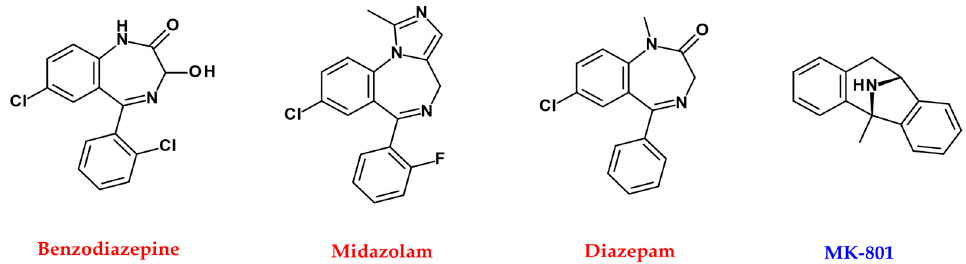
Figure 5. Chemical structures of agonist (red), antagonist (blue), and enzyme inhibitors or others (purple) related to GABA, glutamate neurotransmitters.